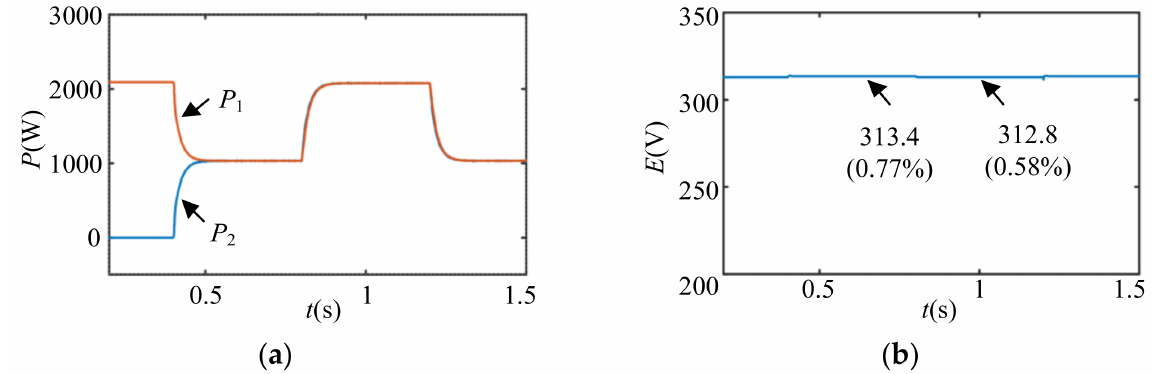
Figure 7. Numerical simulation results with proposed TSMC-based P-U/Q-f droop controller: ( a ) active power sharing of parallel-connected inverters; ( b ) voltage amplitude of point of common coupling (PCC)